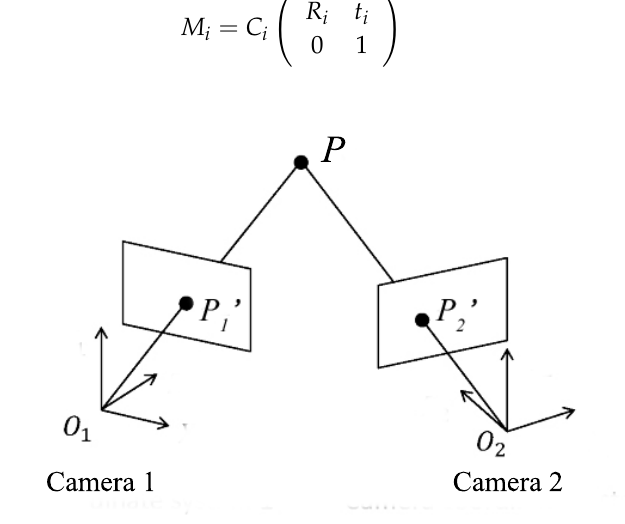
Figure 13. Two-view